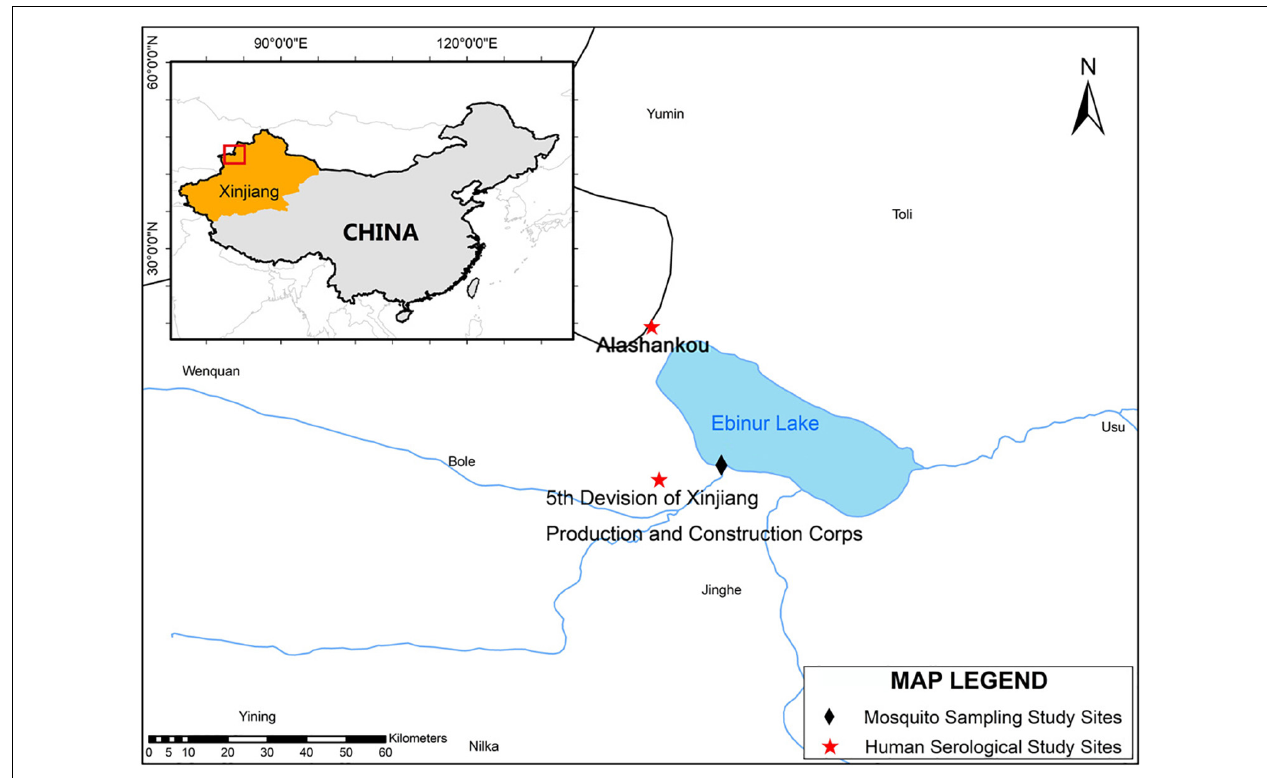
FIGURE 1 | The mosquito collection and serological study sites map. The map and the associated shapefiles were constructed and obtained from the free and open source Quantum GIS software (https://qgis.org/en/site/) and DIVA-GIS platform